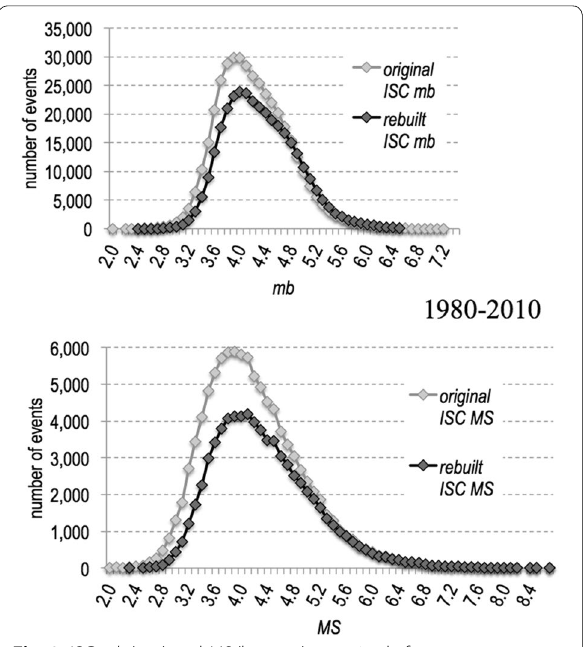
Fig. 7 Annual distribution of the original and rebuilt ISC mb (top) and MS (bottom) magnitudes